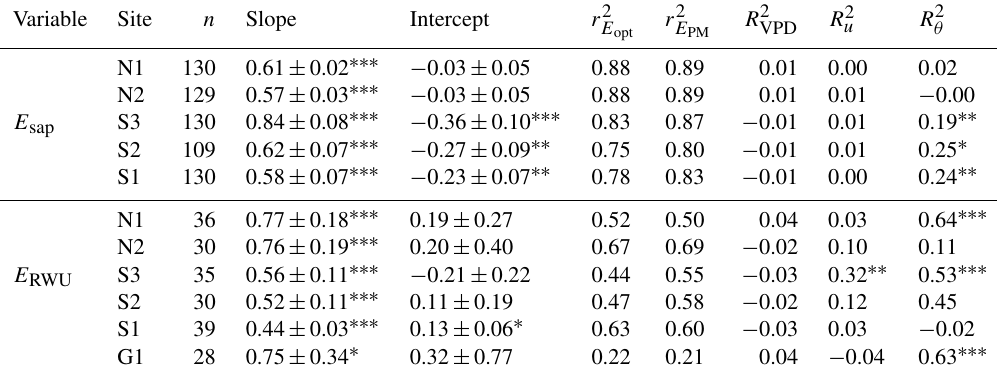
Table 2. Regression statistics for E sap and E RWU to E opt , with n providing the number of observations (days). The slope and intercept are reported with the estimated standard deviation of the coefficients with ± σ . Significance of the coefficients is indicated by stars: p < . 001, ∗∗∗ ; p < . 01, ∗∗ ; p < . 05, ∗ . r 2 r 2 E opt and E PM , respectively. The last three E opt and E PM are the linear squared correlation coefficients to columns report the adjusted explained variance of a linear regression of the regression residuals for daily average vapor pressure deficit ( R 2 ), daily average wind speed ( R 2 u ), and daily site-average volumetric water content ( R 2 θ VPD